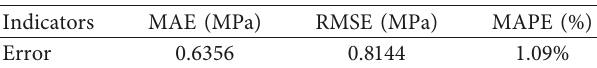
Table 10: Errors of the prediction values and true